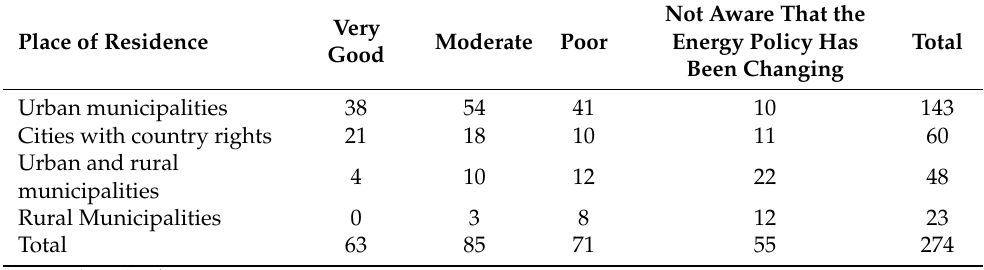
Table 3. Residents’ knowledge of the assumptions of the draft Energy Policy of Poland until 2040.